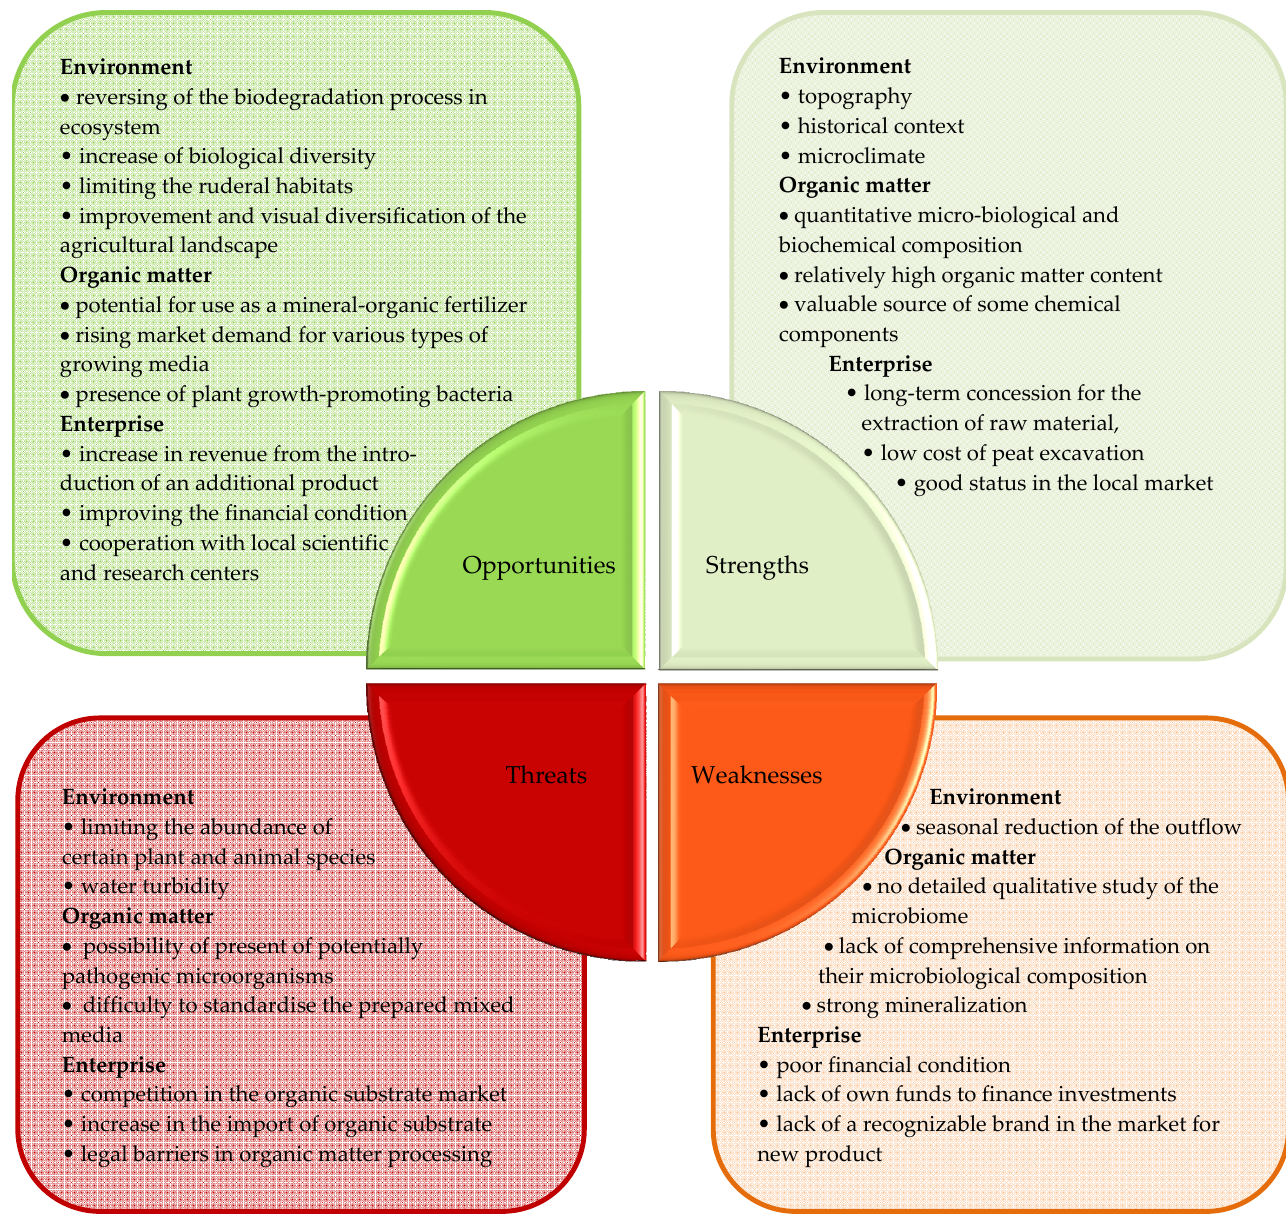
Figure 9. Strength, Weakness, Opportunity, and Threat (SWOT) analysis for the relationships between the environment, organic matter, and enterprise.